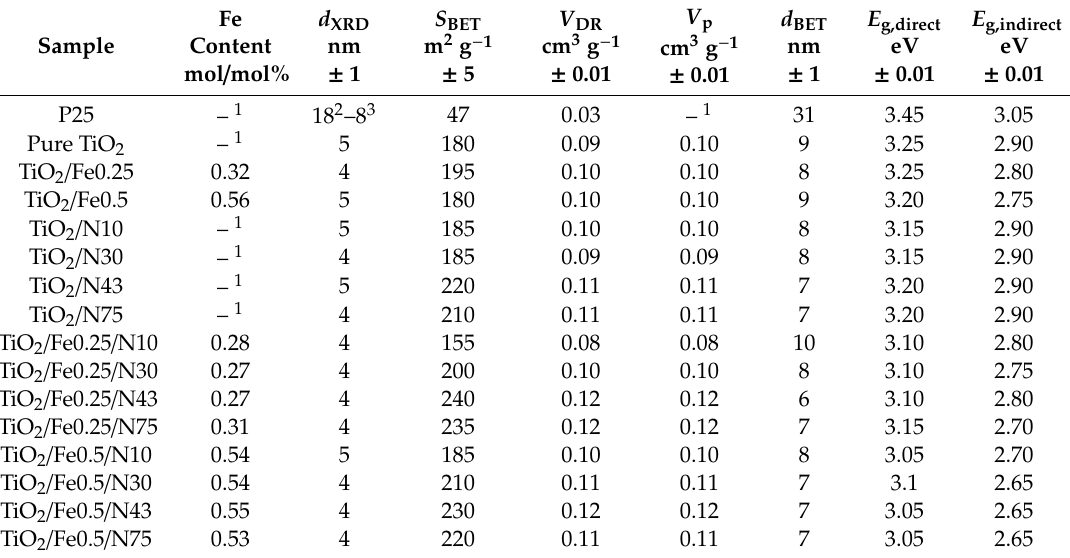
Table 1. Textural and optical properties of TiO 2 -based photocatalysts.